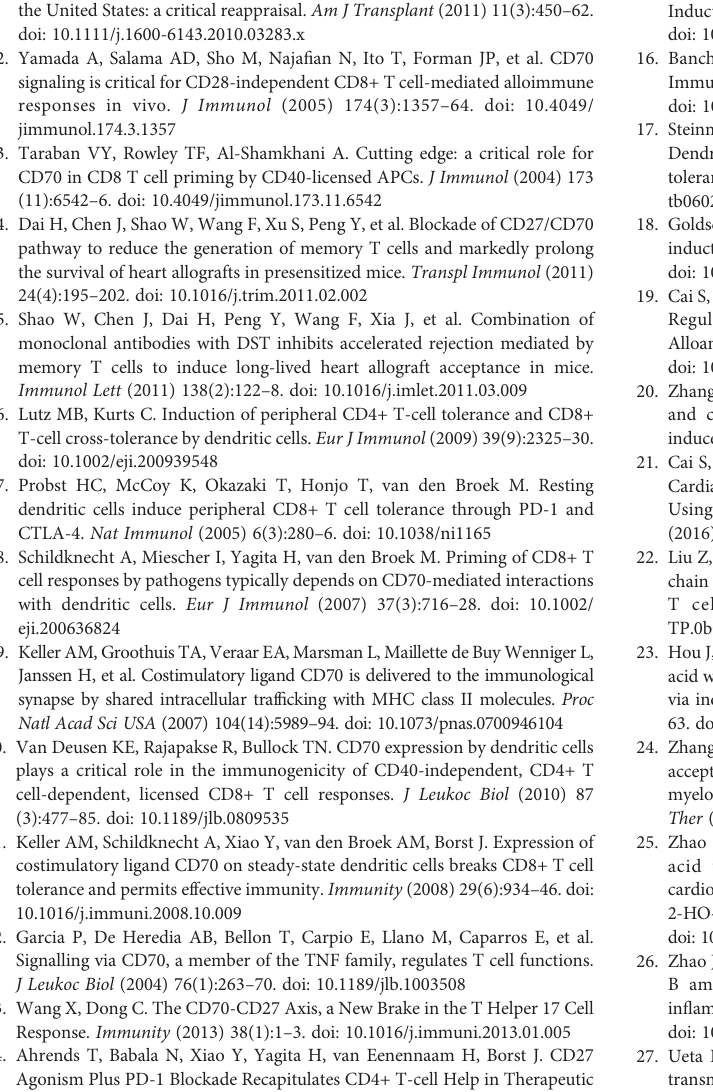
gated onsinglets. Then CD3 + lymphocytes were selected. Finally, further analysis of CD4 + and CD8 + cells on CD3 + cells was performed, and the following phenotypic characteristics were used to de fi ne different populations of memory T lymphocytes: CD4 or CD8 T EM and T CM − CD44 + CD62L − and CD44 + CD62L + , respectively. Supplementary Figure 3 | Gating strategy for the fl ow cytometric analysis of DCs(A)andTregs(B)fromgraftandspleen. (A) Upperpanel:GatingstrategyforDC analysis in graft. CD45 positive cells were gated for singlets based on SSC-H and SSC-W, and then living cells were gated on singlets and examined for expression of CD11c and CD11b. CD11c hi CD11b hi cells representing DCs were used for further analysis. Lower panel: Gating strategy for DC analysis in spleen. Living cells were gated based on forward and side scatter. Doublets were discriminated and living cells were gated on singlets. Living cells were examined for CD11cCD11b double positive cellsrepresenting DCs. (B) Upper panel: Gatingstrategy for Treganalysis in graft. Doublets were discriminated based on SSC-H and SSC-W. CD45 positive